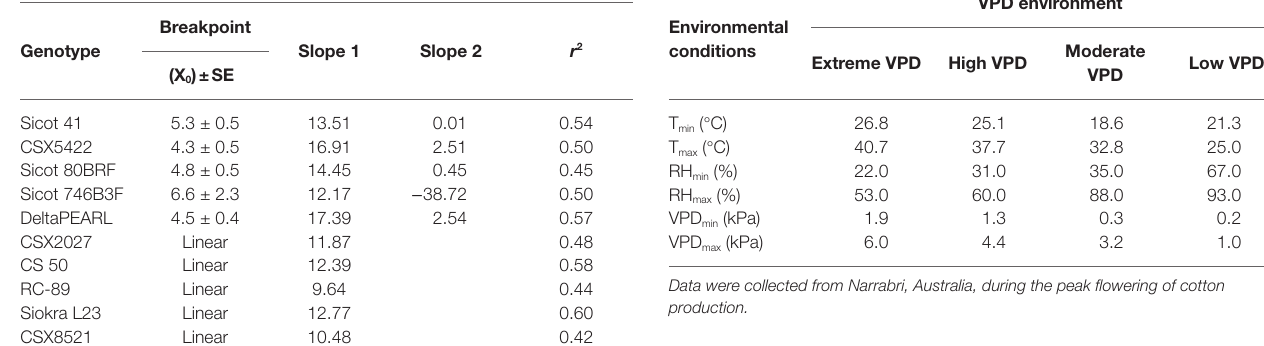
TABLE 2 | Breakpoint, slope, and r 2 results from regression analyses of the transpiration response of 10 cotton genotypes to VPD.